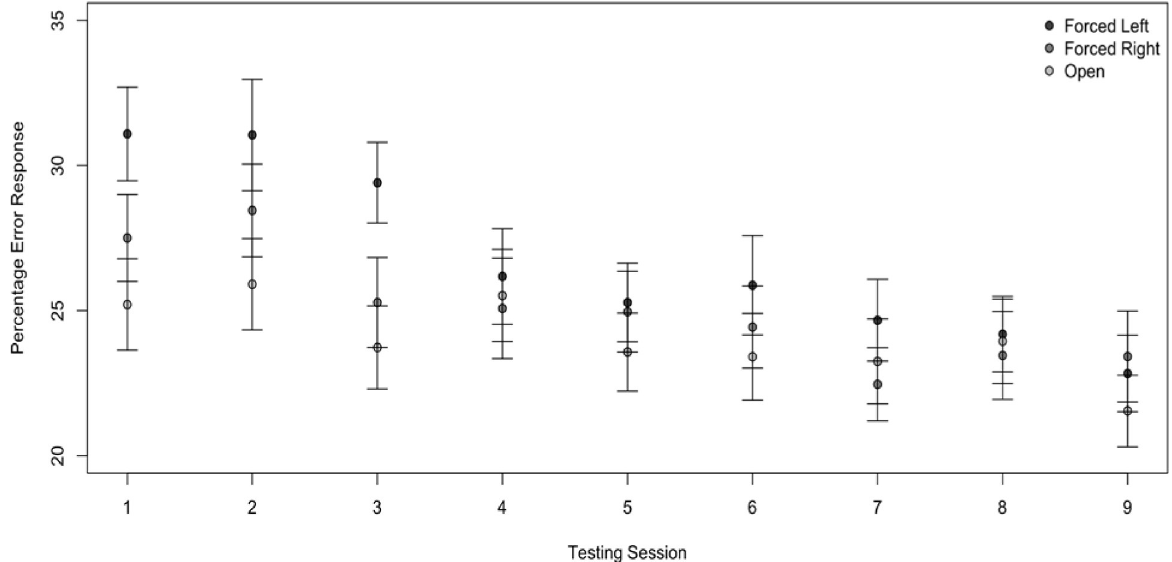
Fig 5. Percentage of error responses as a function of listening condition and testing session. Mean and standard error of the error responses for the three listening conditions over the nine testing sessions.